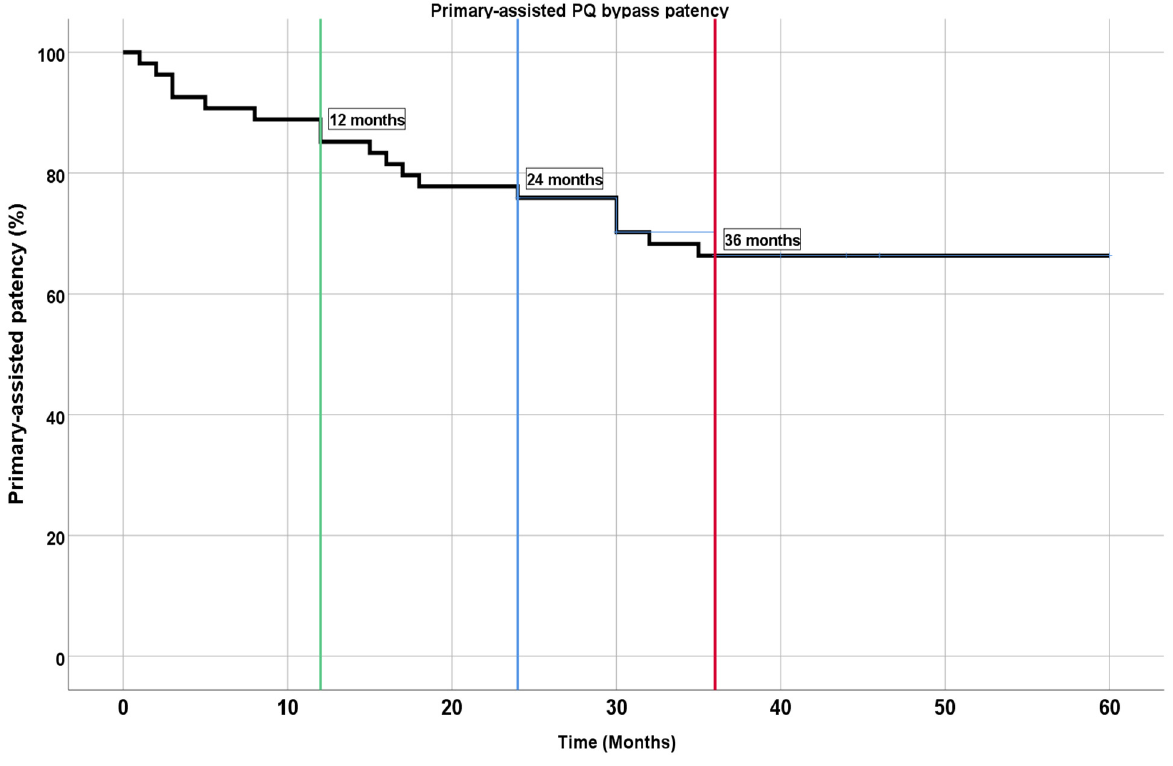
Figure 4. Kaplan–Meier plot for primary-assisted patency at 1 year (green line), 2 years (blue line), and 3 years (red line).